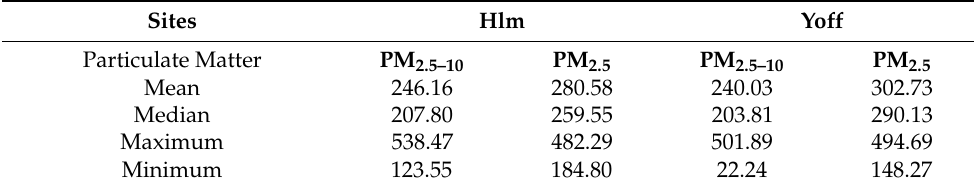
Table 1. Particulate matter (PM) 2.5–10 and PM 2.5 mass concentrations at Hlm and Yoff sites during the study period in µ g m − 3